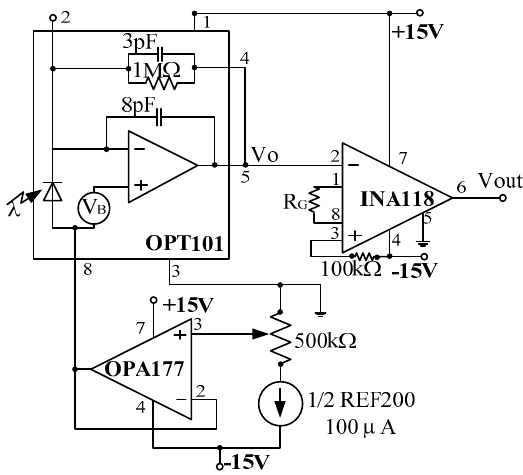
Figure 5. Light intensity to voltage converter circuit connections.